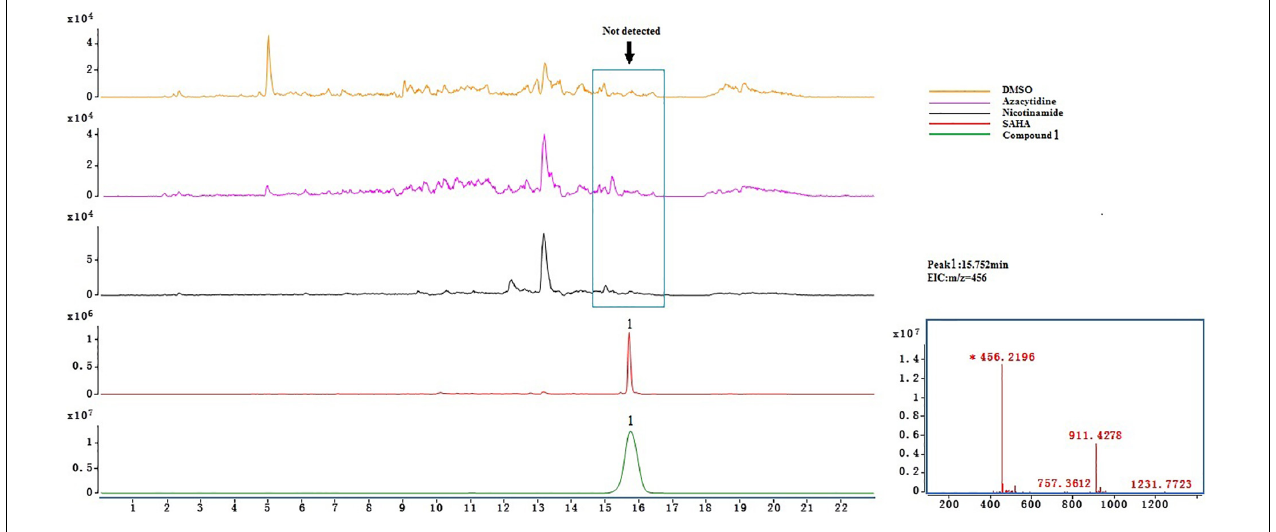
FIGURE 3 | UHPLC-QTOF-MS analysis of compound 1 in different samples. TABLE 2 | The IC 50 values of compounds 1 – 4 against the tested phytopathogens (in µ